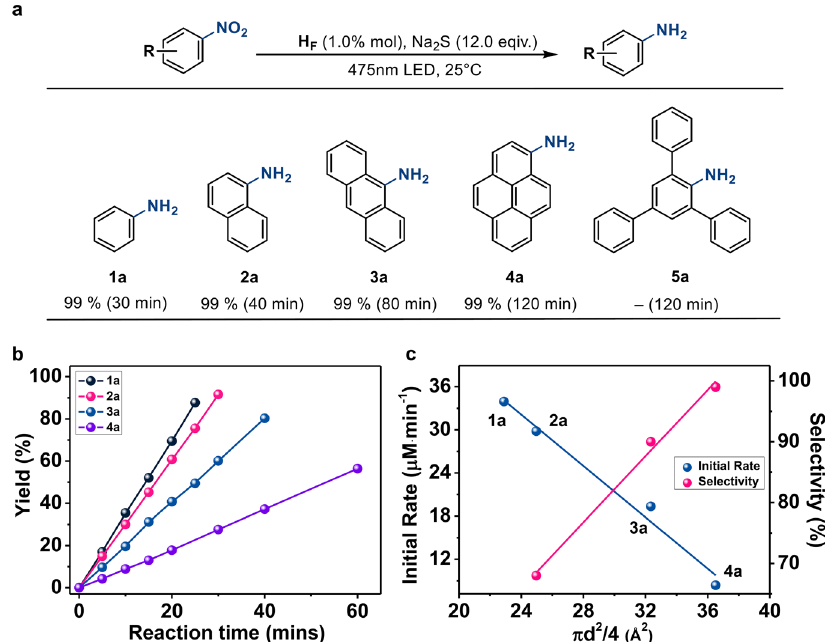
Fig. 3 Photoreduction of nitroarenes into aminoarenes. a Photoreduction of nitroarenes into aminoarenes under standard conditions: H F (0.50 μ mol), Na 2 S (0.60 mmol) and substrate (0.05 mmol) at 25 °C in 5.0 mL CH 3 CN/ H 2 O (4:1 in volume) with 475 nm LED; the isolated yields were measured by 1 H NMR. b Kinetics of the aminoarenes conversion with varied substrates under standard conditions. c Initial rates and selectivity of aminobenzene over the competing amino products in the reaction mixture containing 0.025 mmol nitrobenzene and competing nitroarene under standard conditions as a function of the estimated diameter (d) of substrates (shown as π d 2